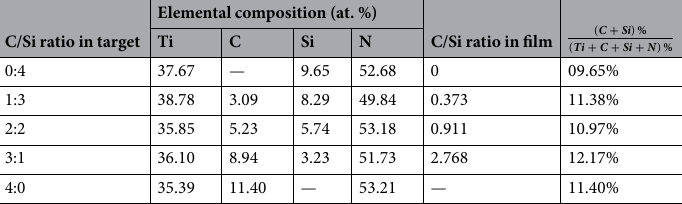
Table 1. Compositions of as-deposited TiSiCN films, as determined by EDS.